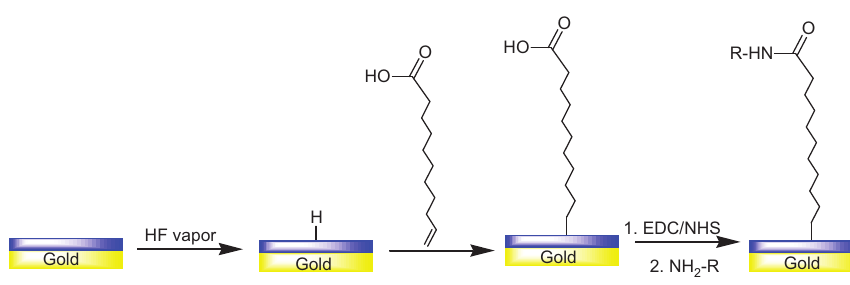
Figure 13 Surface hydrogenation of a -Si